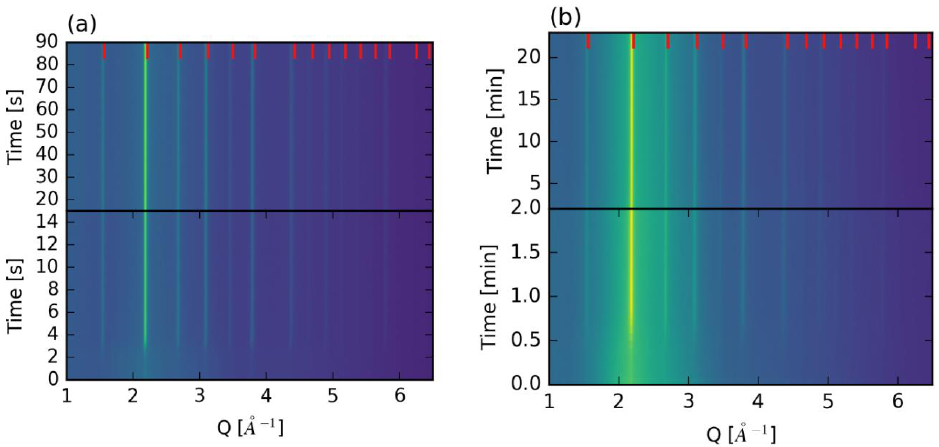
Figure 1. Color map plots showing the formation of BaTiO 3 at 150 °C and 200 bar (colors yellow-blue show intensity from high to low): ( a ) Ti-slurry-150 and ( b ) Ti-CAsol-150. Red markers show diffraction lines for bulk cubic BaTiO 3 at RT from ICDD card #01-074-4539, and the offset is an effect of temperature and finite-size effects. Notice the different time scales.